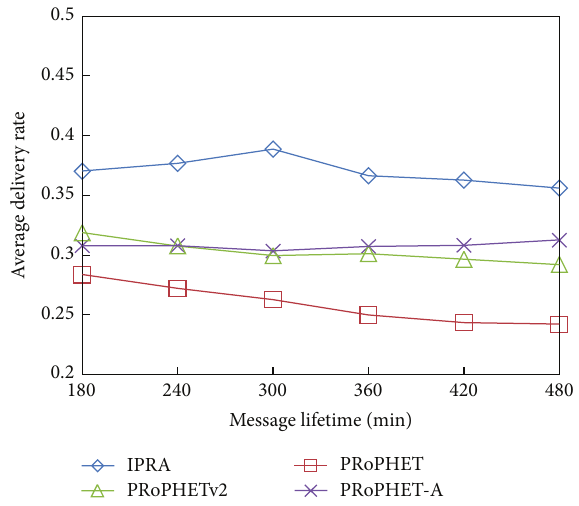
Figure 8: Average overhead (AO) versus buffer size.